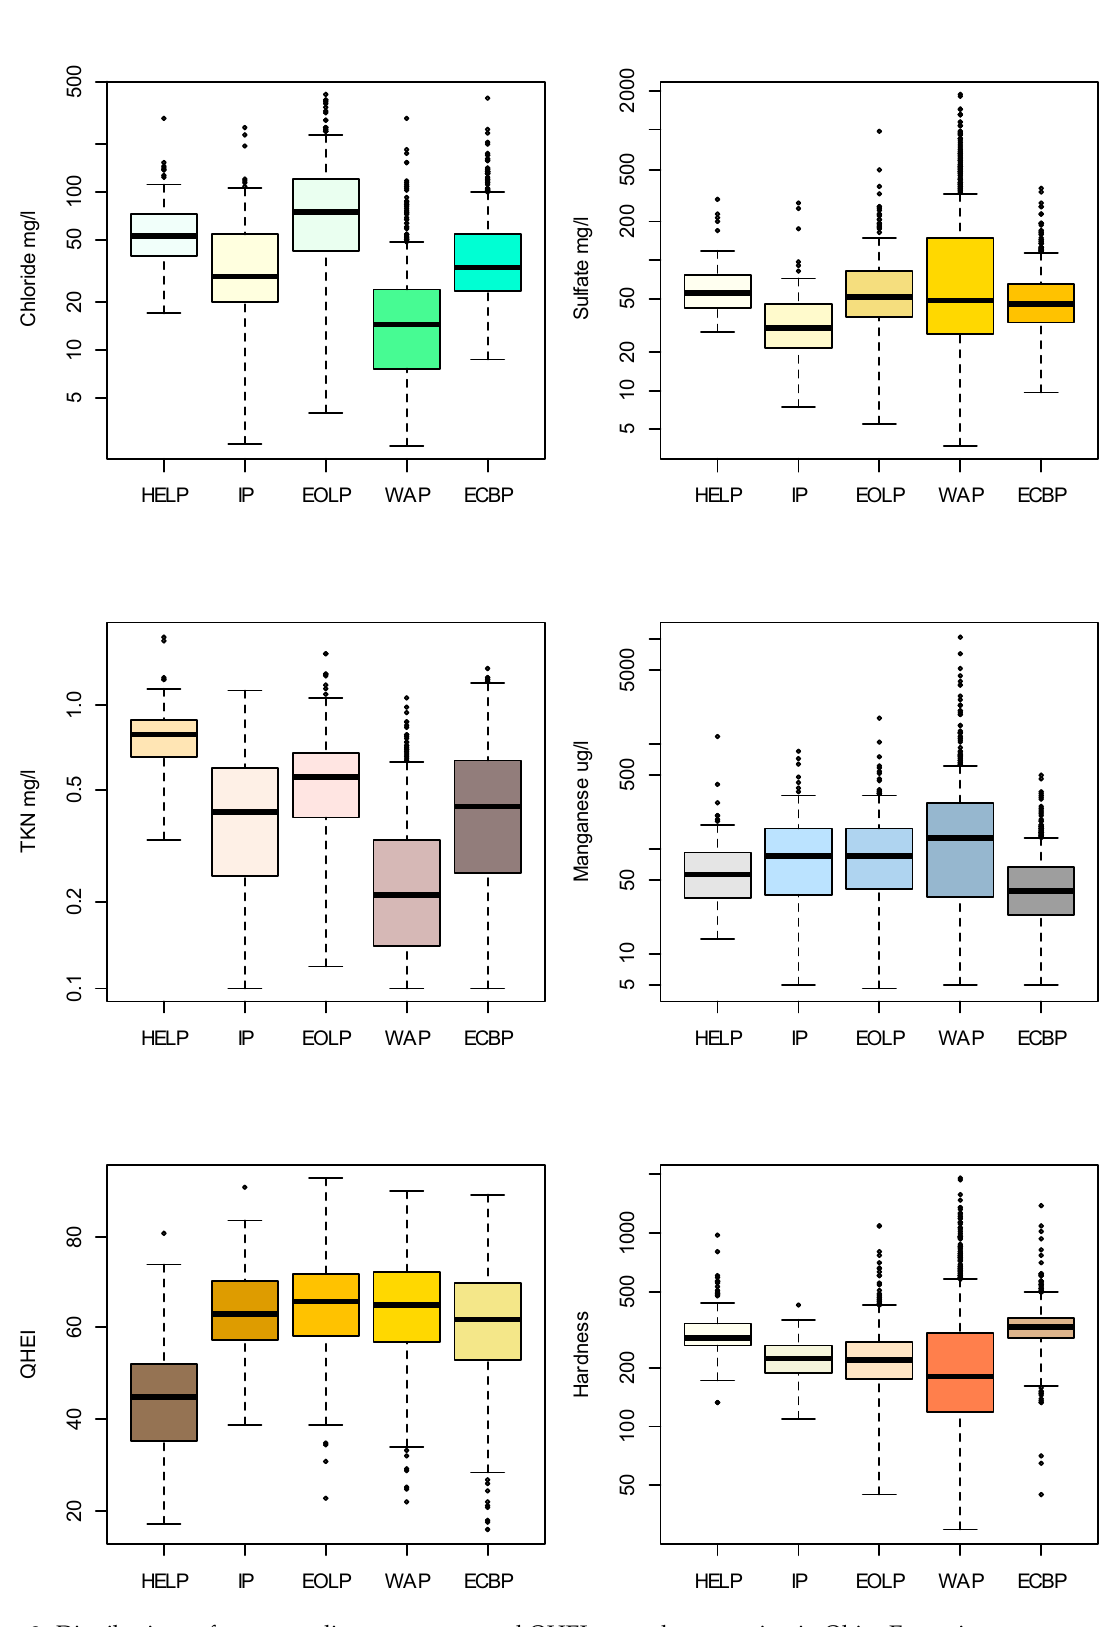
Figure 3. Distributions of water quality parameters and QHEI scores by ecoregion in Ohio. Ecoregion acronyms are as follows: HELP—Huron-Erie Lake Plain; IP—Interior Plateau; EOLP—Erie-Ontario Lake Plain; WAP—Western Allegheny Plateau; ECBP—Eastern Corn Belt Plains. Note that the y-axes for the water chemistry constituents are log10-scaled.